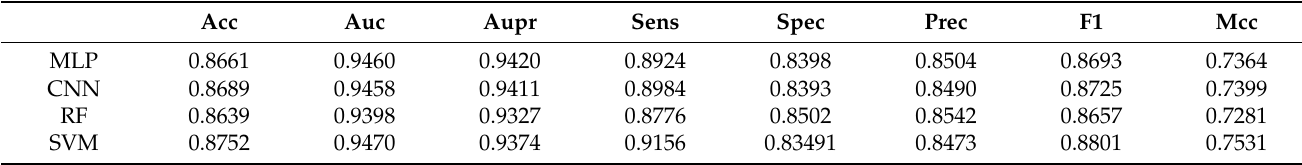
Table 1. The performance comparison of different